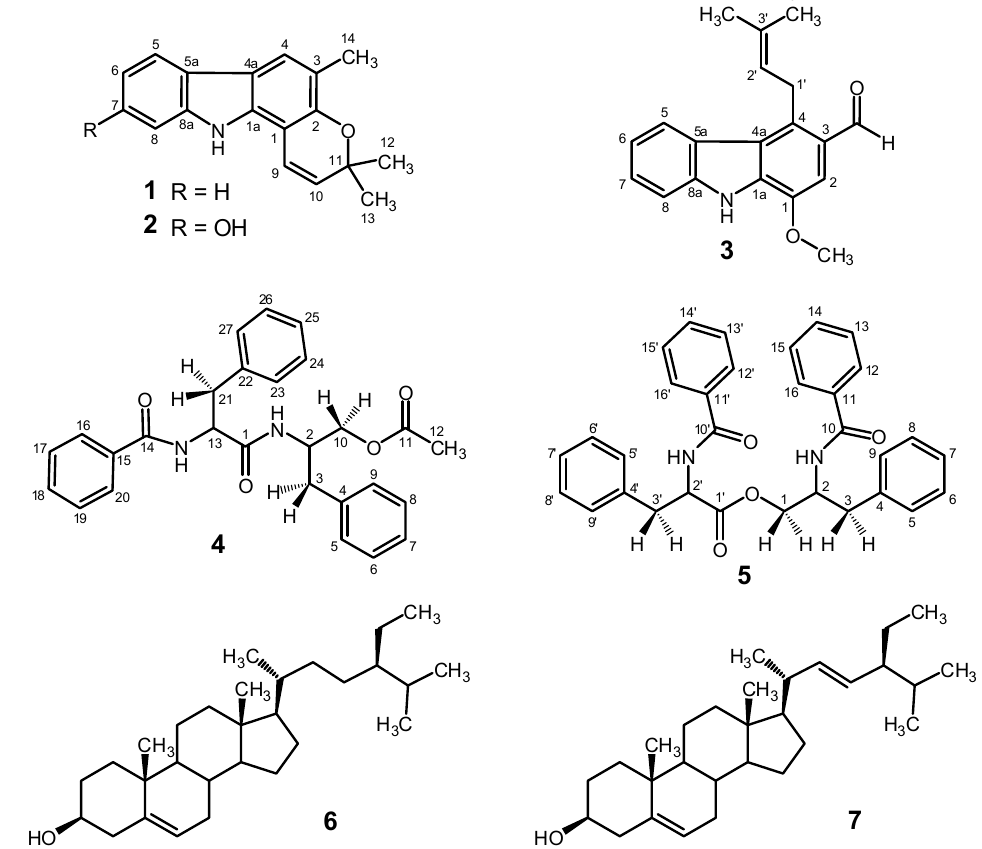
Figure 1. The structures of seven chemical constituents isolated form Clausena anisata